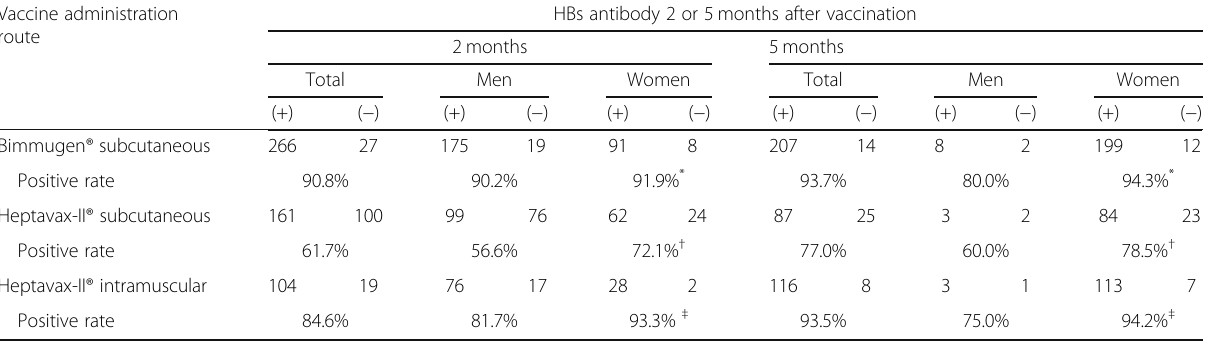
Table 3 Hepatitis B virus surface (HBs) antibody positive rate according to the time between vaccination and the HBs antibody test Vaccine administration